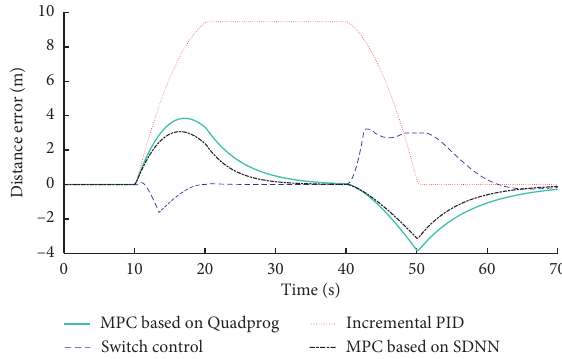
Figure 19: Distance errors of the LV and the FV of four controllers. Table 13: Performance in the go-stop condition.